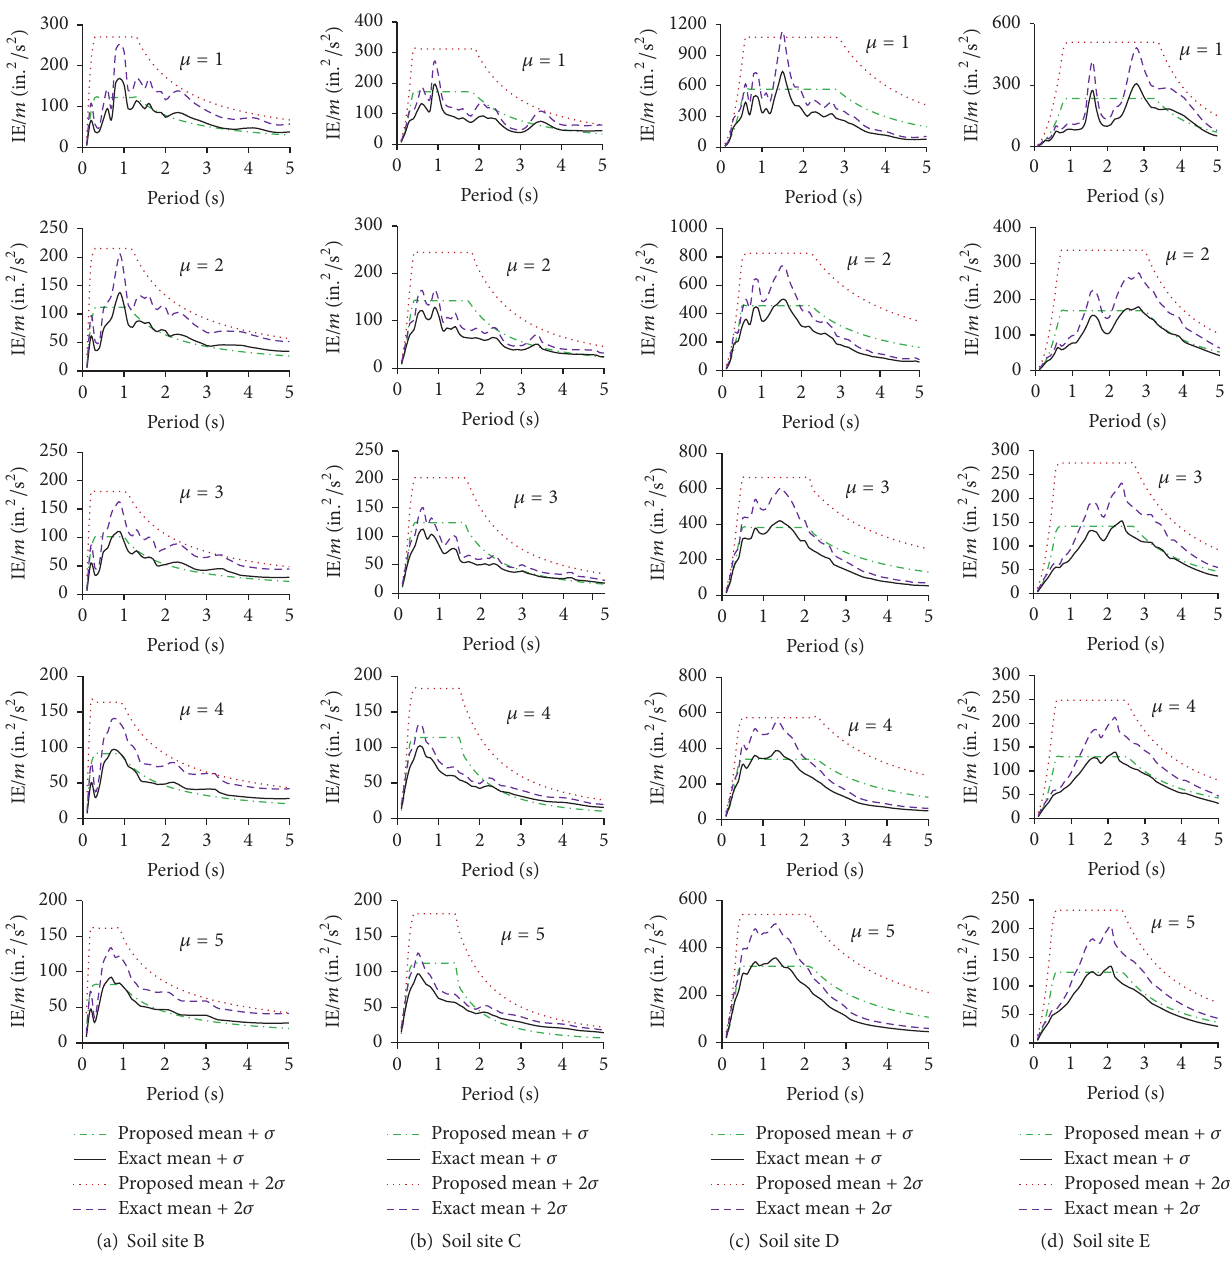
Figure 6: Comparative study of proposed input energy spectra: hysteresis model BP (𝜁 = 5 %, 𝛼 = 0.05)